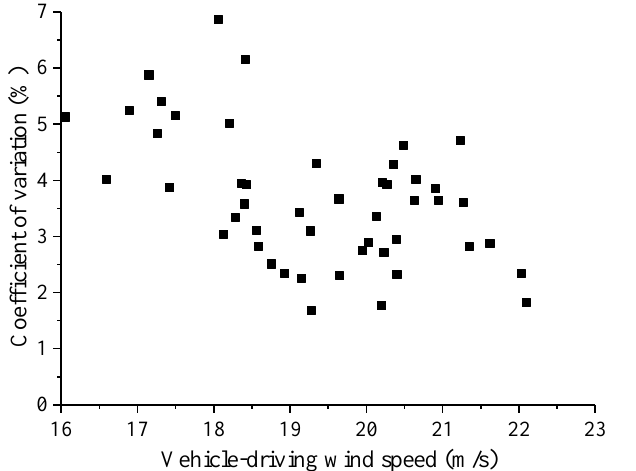
Figure 7. Coefficient of variation of vehicle-driving wind speed of the wind field measured on the expressway.